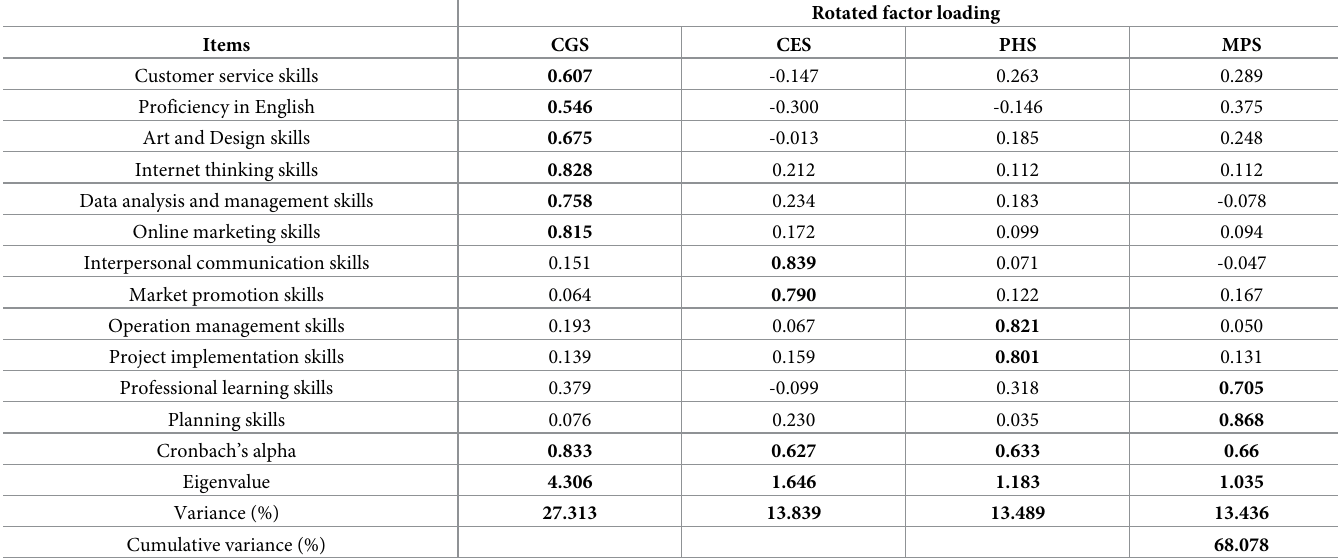
Table 3. EFA for MICE employability competences and